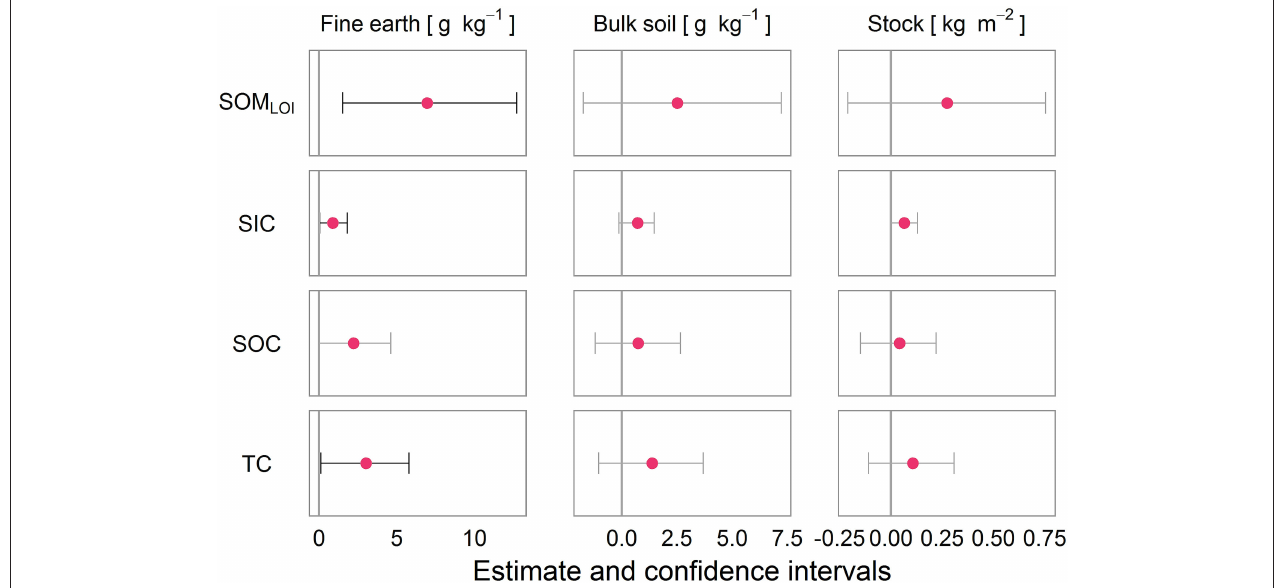
FIGURE 5 | Comparison of long-term vs. short-term urban soils, estimating fixed effects of model coefficients and 95% confidence intervals (CI) of the linear mixed models for SOM LOI , soil organic matter obtained from loss on ignition; SIC, soil inorganic carbon; SOC, soil organic carbon; and TC, total carbon. Positive values indicate an increase of the respective soil variable in long-term urban soils, whereas negative values indicate a decrease in long-term urban soils compared to short-term urban soils. Error bars that do not cross the zero line indicate statistical